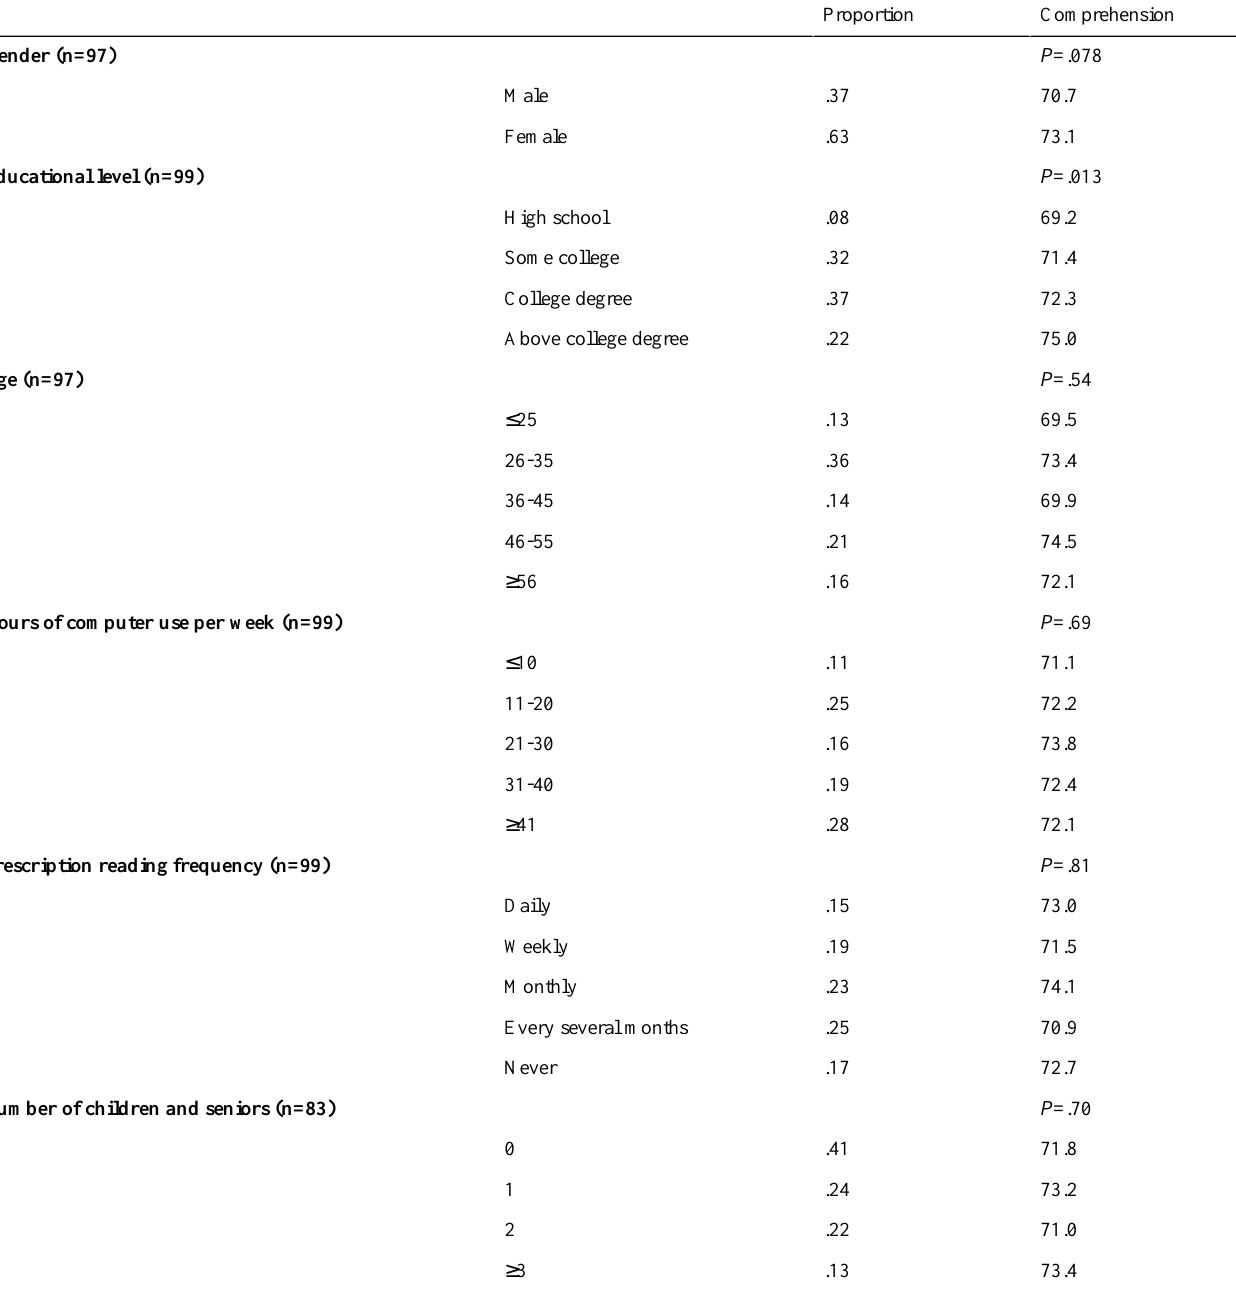
Table 2. Participant demographics and pictogram comprehension